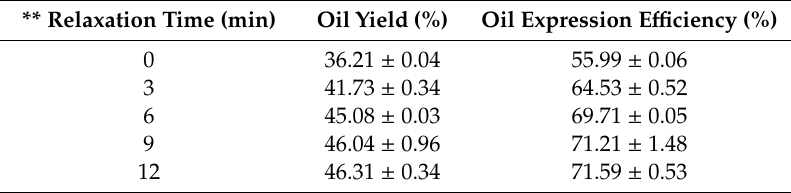
Table 3. E ff ect of relaxation time on sample heating temperature of 60 ◦